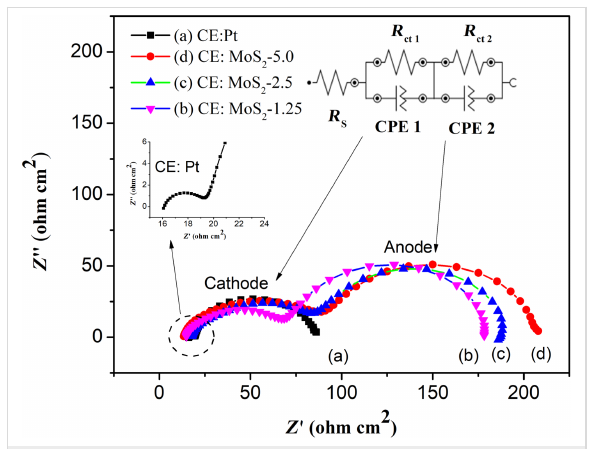
Figure 6: Nyquist plots of DSSCs using different MoS 2 /FTO and Pt/ FTO CEs, the inset shows the equivalent circuit model.